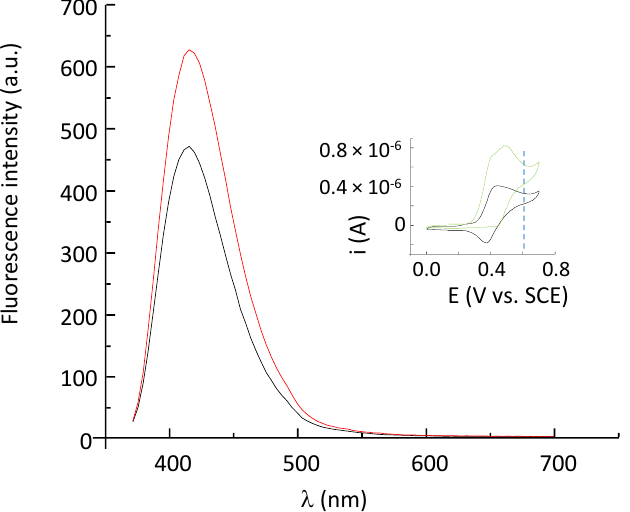
Figure 8. Fluorescence emission spectra of a 1:10 mixture of P797 and imidazole before and after electrolysis ([P797] = 5.10 − 6 mol.dm − 3 , [Imidazole] = 5.10 − 5 mol.dm − 3 in acetonitrile + TBABF 4 0.1 mol.dm − 3 ). Black curve: before electrolysis (Species A in Scheme 2). Red curve: after a 3 Faraday/mole oxidation at 0.6 V/SCE (Species E in Scheme 2). Inset: CVs recorded before electrolysis. Black curve: no imidazole added. Green curve: addition of a tenfold excess of imidazole (the vertical blue dashed line shows the potential applied for the electrolysis): Excitation wavelength λ ex = 350 nm .